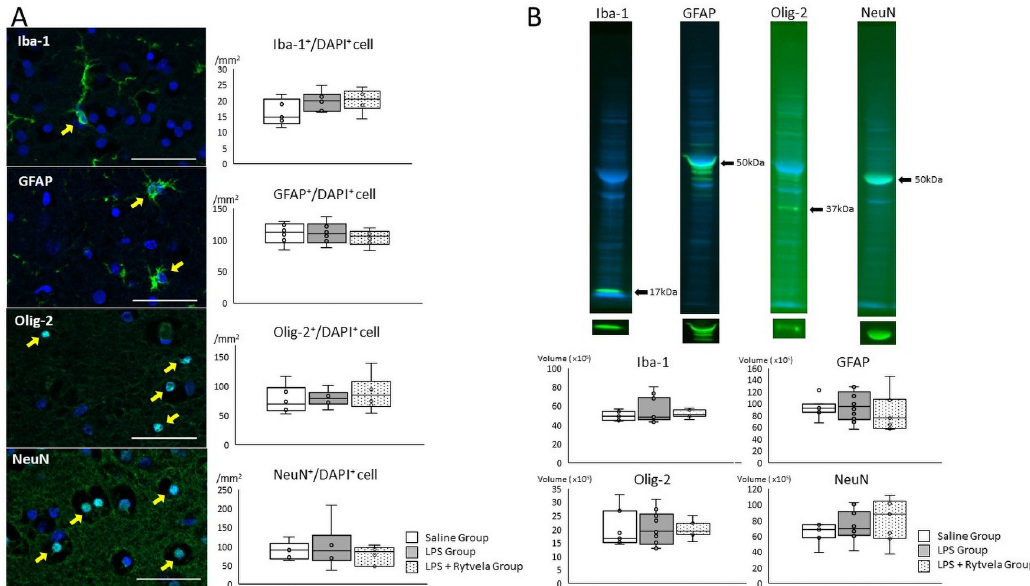
Fig 8. Fluorescent immunohistochemistry and western blotting assessment of fetal brain. A , Representative photomicrographs show Iba-1-, GFAP-, Olig-2- and NeuN- positive (green) / DAPI positive (blue) cells in subcortical white matter of the Saline Group animals. Positive cells are indicated by arrows . Scale bar : 50 μ m. Box plots show the numbers of counting Iba-1-, GFAP-, Olig-2- and NeuN- positive / DAPI positive cells of three groups. B , Representative images show Iba-1, GFAP, Olig-2 and NeuN specific band (green) and total protein stained band (blue) of the quality control animal (Saline Group animal). Box plot show the band volume of the each antibody against the total protein amounts. Plots show median, 25th, and 75th percentile ranges as boxes and 5th to 95th percentile as error bars. n = 6–8 animals/group. Iba-1, ionized calcium-binding adapter molecule 1; GFAP, glial fibrillary acidic protein; Olig-2, oligodendrocyte transcription factor 2; NeuN, neuronal nuclei. https://doi.org/10.1371/journal.pone.0257847.g008 was significantly lower than that of animals from the LPS Group. Previous studies have identi- fied the fetal skin is as a pro-inflammatory organ following intrauterine endotoxin exposure in the preterm sheep [29, 30]. We previously demonstrated that selective exposure of fetal skin + amnion to LPS induce acute systemic inflammation [31] and significant elevation of mRNA expression for IL-1 β in fetal skin persisted till 15 days after LPS exposure [32], while that in